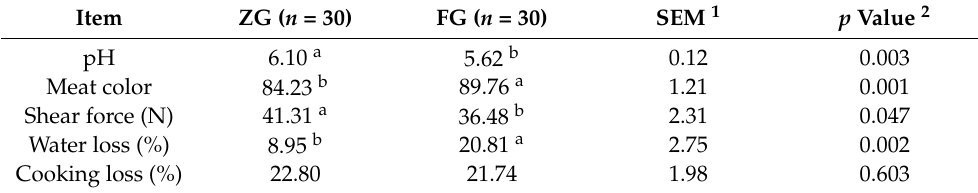
Table 2. Breast muscle physical properties in the ZG and FG.